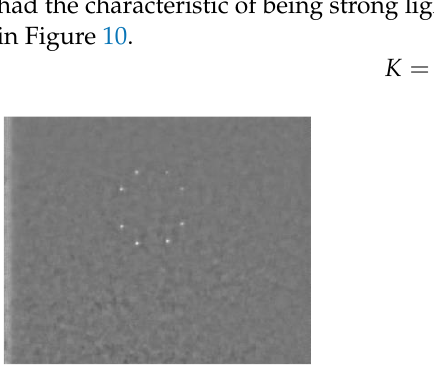
Figure 10. Image K ( 22